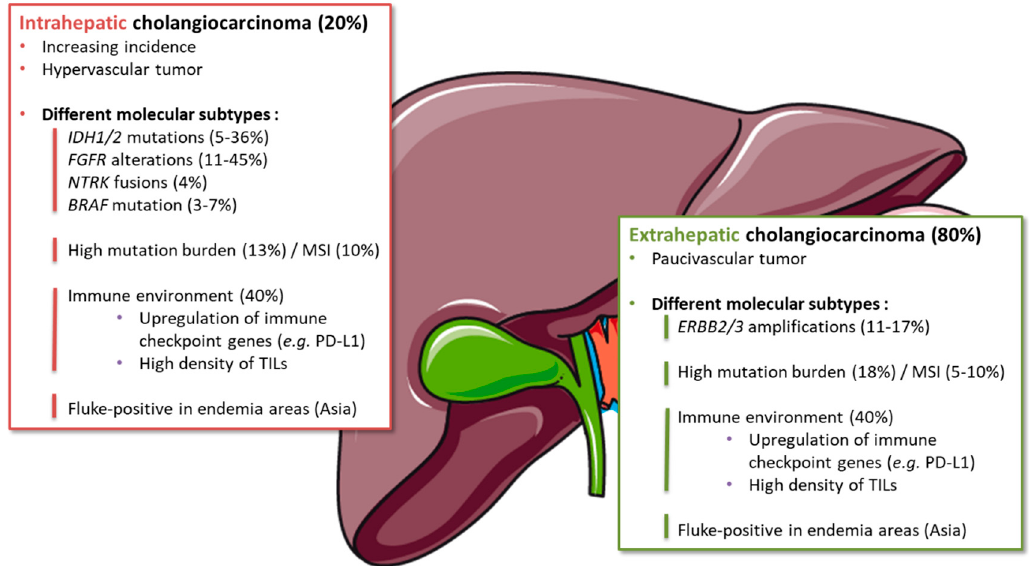
Figure 2. Molecular and immune subgroups in the different anatomical subtypes of biliary tract cancer. Abbreviations: ERBB: erb-b2 receptor tyrosine kinase; FGFR: fibroblast growth factor receptor; IDH: isocitrate dehydrogenase; MSI: microsatellite instability; NTRK: neurotrophic tyrosine receptor kinase; PD-L1: programmed death ligand-1; TIL: tumor infiltrating lymphocytes.